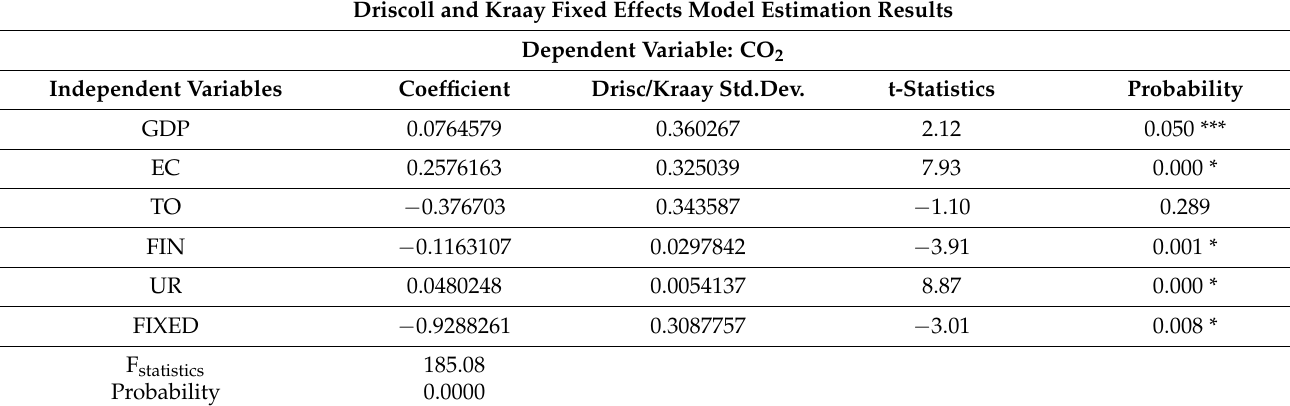
Table 9. Final model- Driscoll-Kraay estimator—One-way (unit) fixed effects model. Driscoll and Kraay Fixed Effects Model Estimation Results